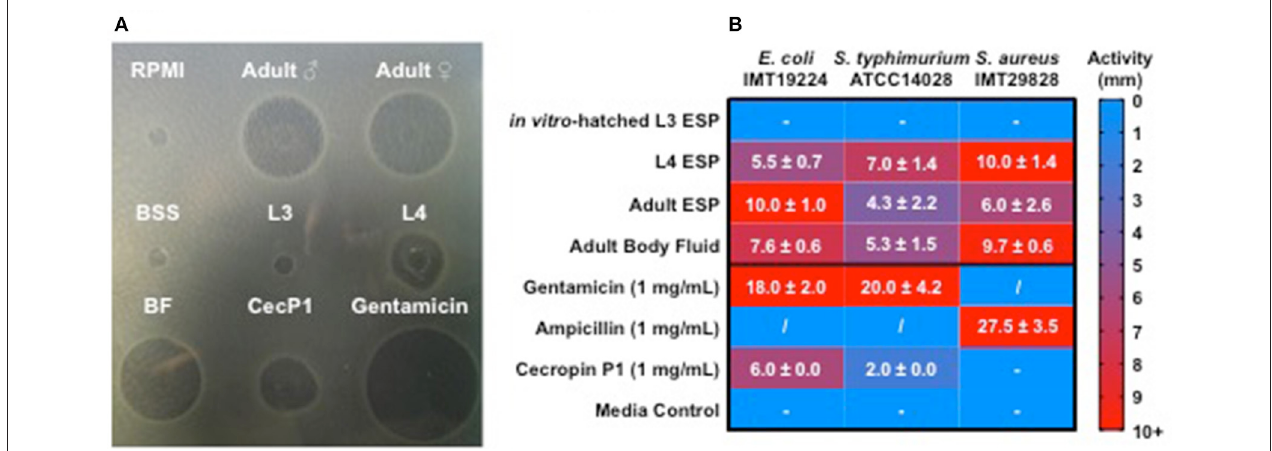
FIGURE 1 | Ascaris suum excretory/secretory products and body fluid possess antimicrobial activity. Five microliter of nematode products were applied to agar plates with proliferating bacteria for 18h at 37 ◦ C and growth inhibition zones measured in millimeters. Ascaris products tested include native excreted and secreted products (ESP) from adult worms kept in culture for 24h, body fluid (BF) from adult males, native ESP from approximately 30,000 L3-stage larvae hatched in vitro/ mL media, native ESP from approximately 100 L4-stage larvae/mL media, and a synthetic form of the A. suum antimicrobial peptide, cecropin P1. Larval (RPMI) and adult worm media (BSS) were included as controls. (A) Representative agar plate of a radial diffusion assay, with nematode products tested against E. coli . (B) Activity shown as diameter (mm) of inhibition zones on agar plates. Results are expressed as means ± standard deviations obtained from 2 to 3 independent experiments with multiple